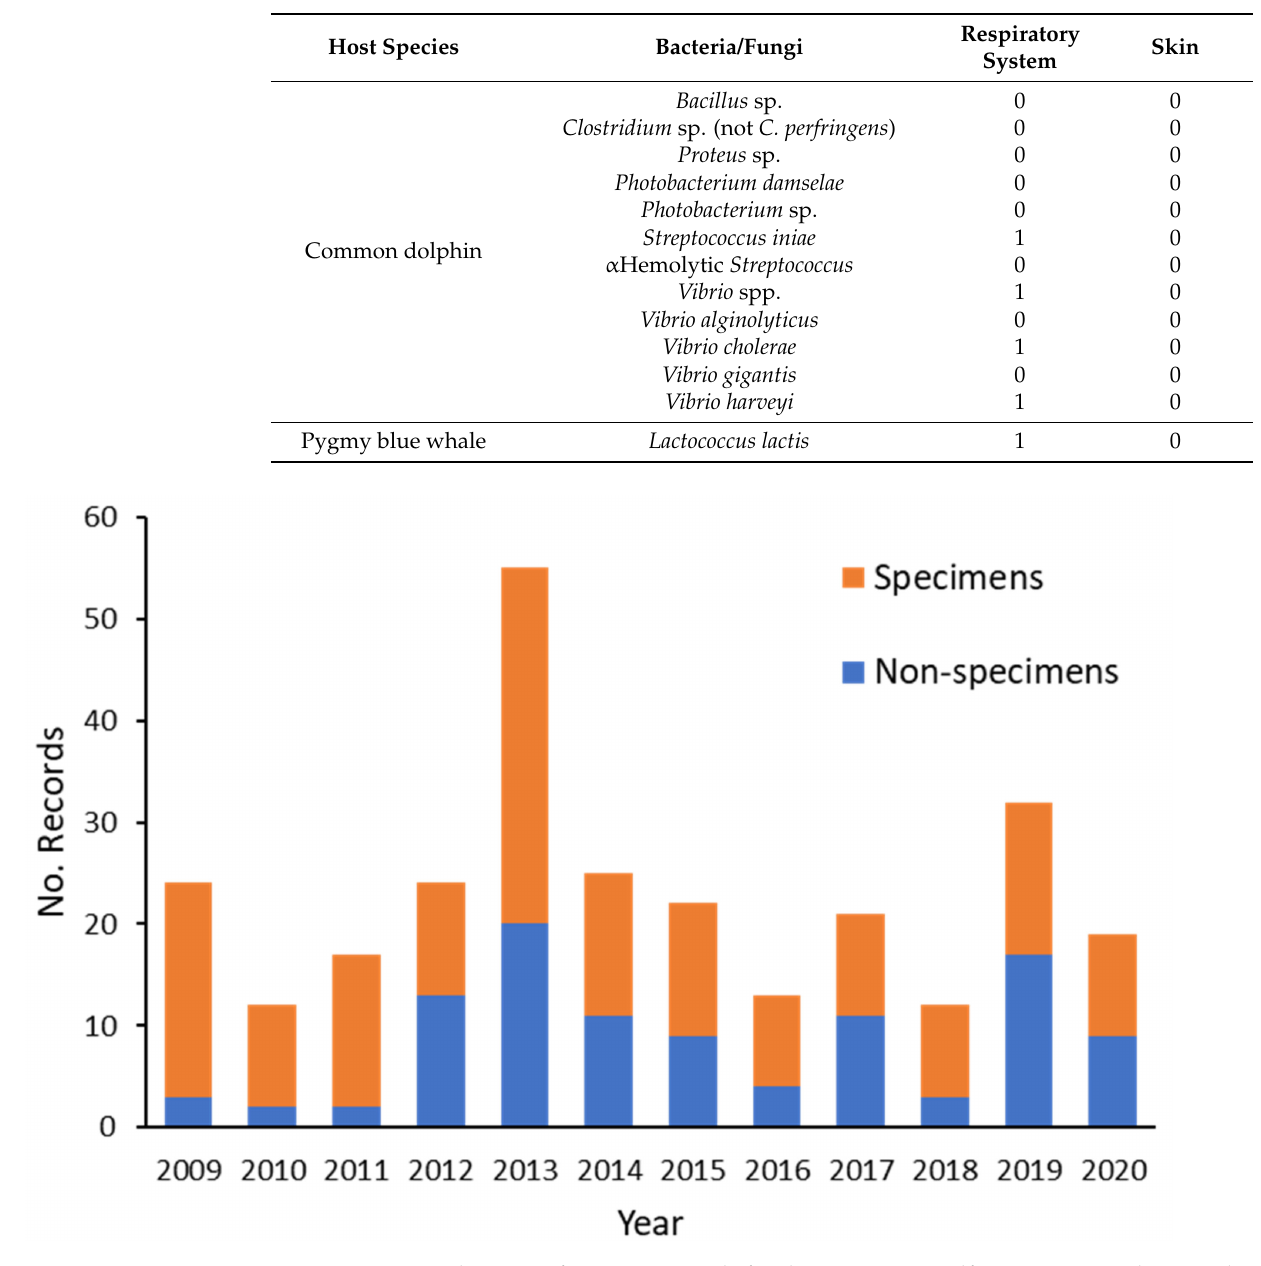
Figure A1. Annual counts of cetacean records for the St Vincent Gulf Bioregion, South Australia, during 2009–2020, divided into specimens collected (specimens) and not collected (non-specimens) for examination and/or